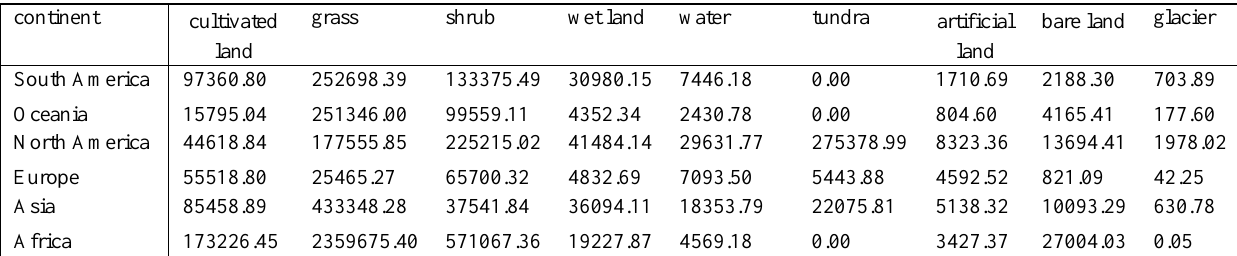
Table3 ： Area that forest transferred to other lands (unit: km 2 )